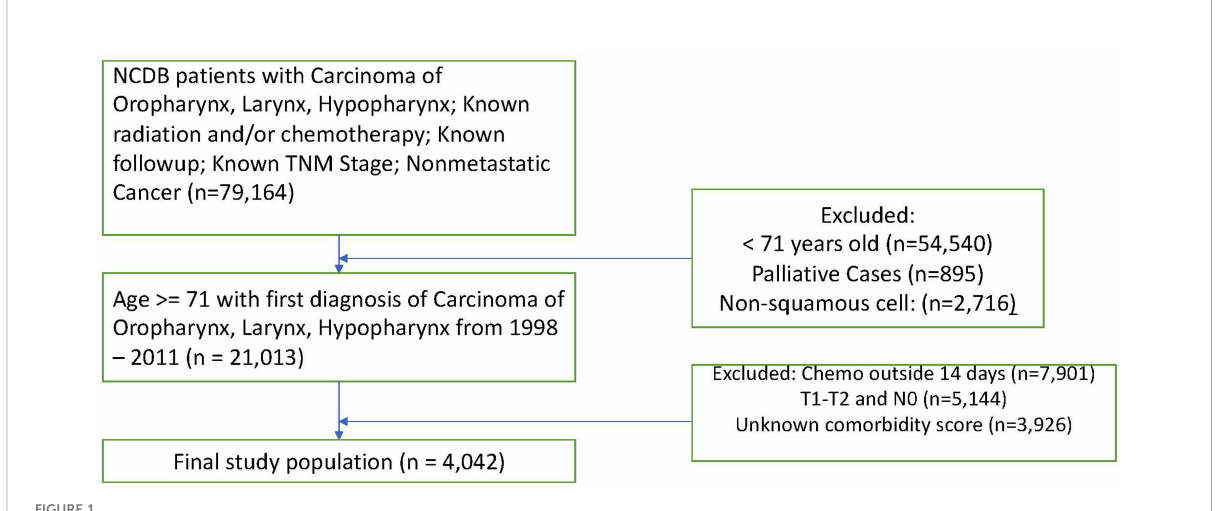
FIGURE 1 Flow diagram for exclusion criteria in study by Amini et